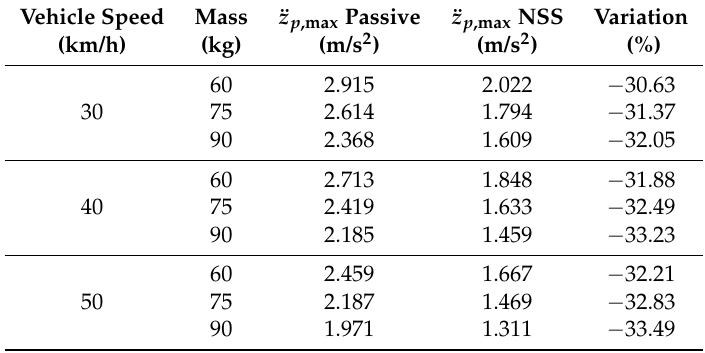
Table 3. Peak acceleration values for a speed bump traversed with different speeds and